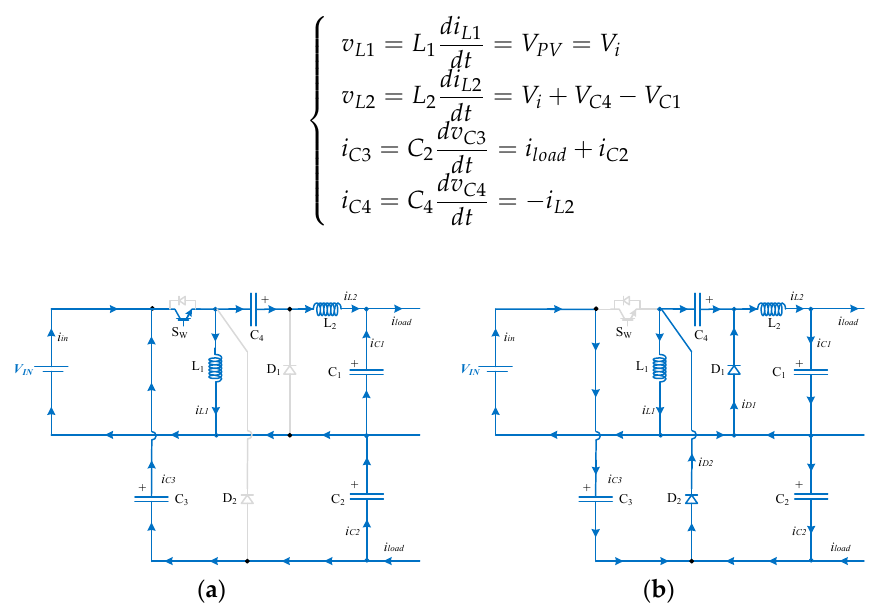
→ ON , ( b ) Mode 2: S → OFF . W W